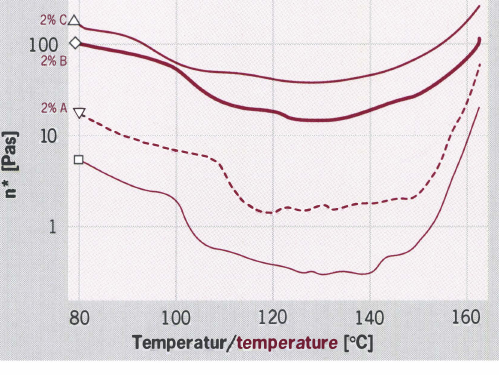
Fig. 5: Influence of pyrogenic silicic acid on the phase shift